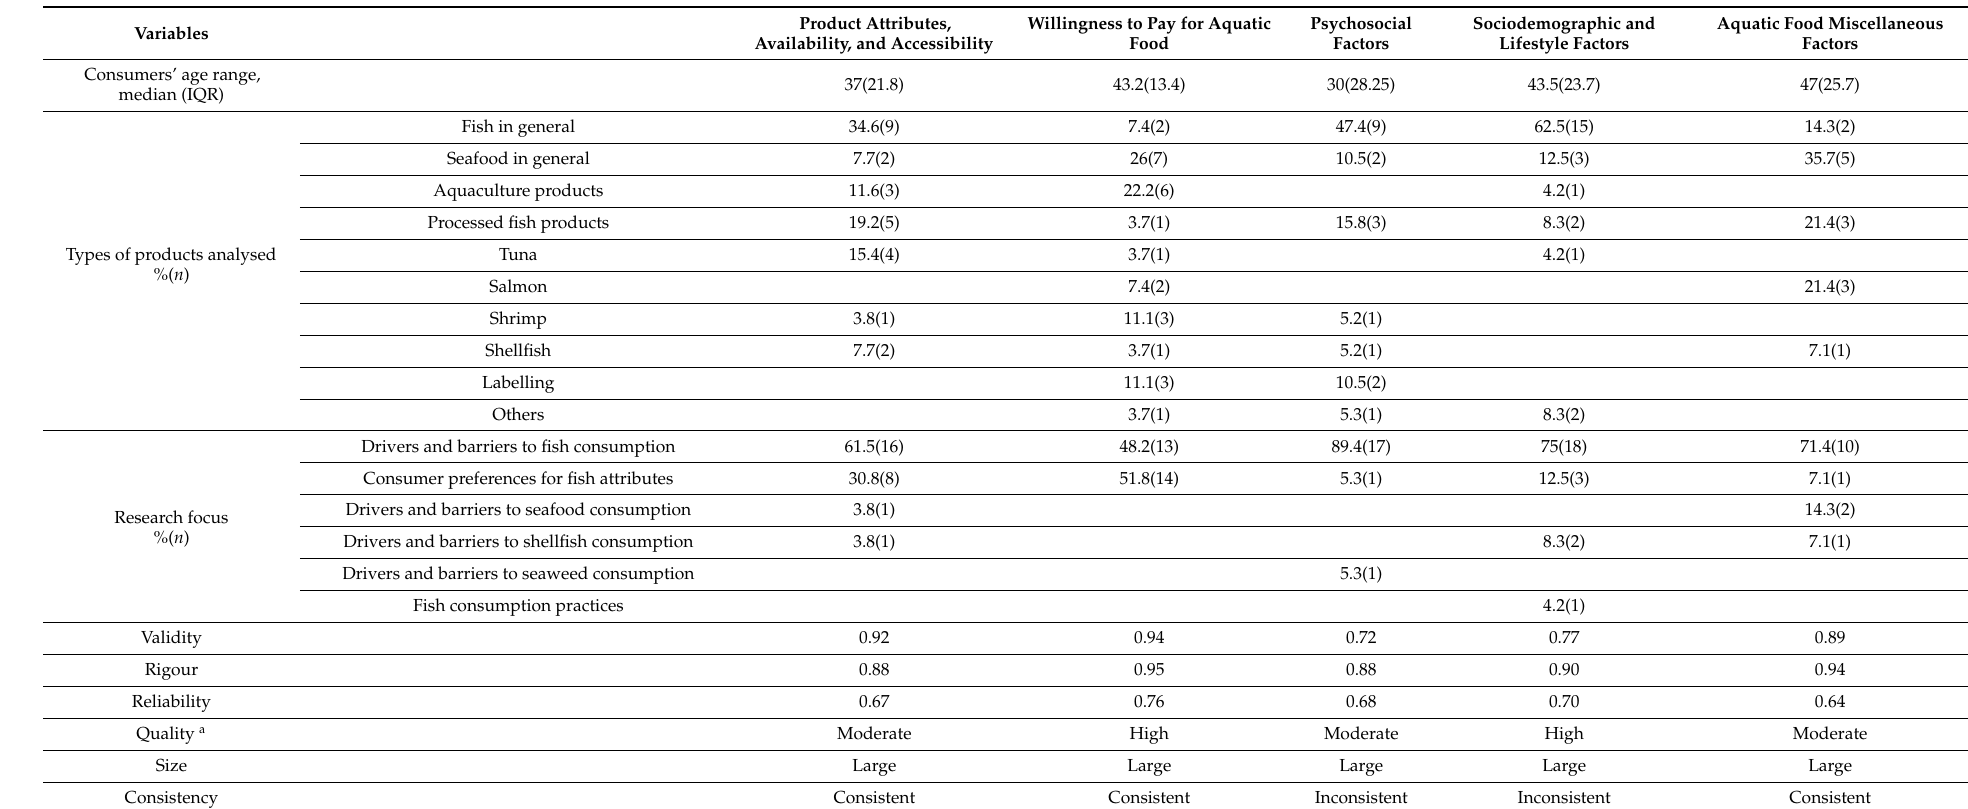
Table 2. Characteristics of the five research clusters and their quality